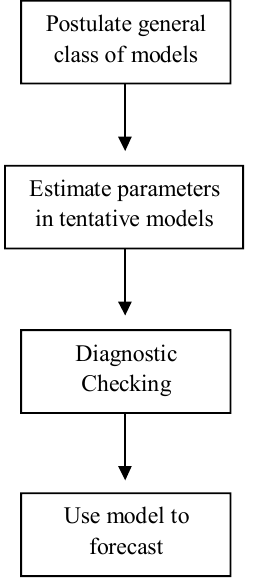
Fig. 1. Schematic representation of the Box-Jenkins